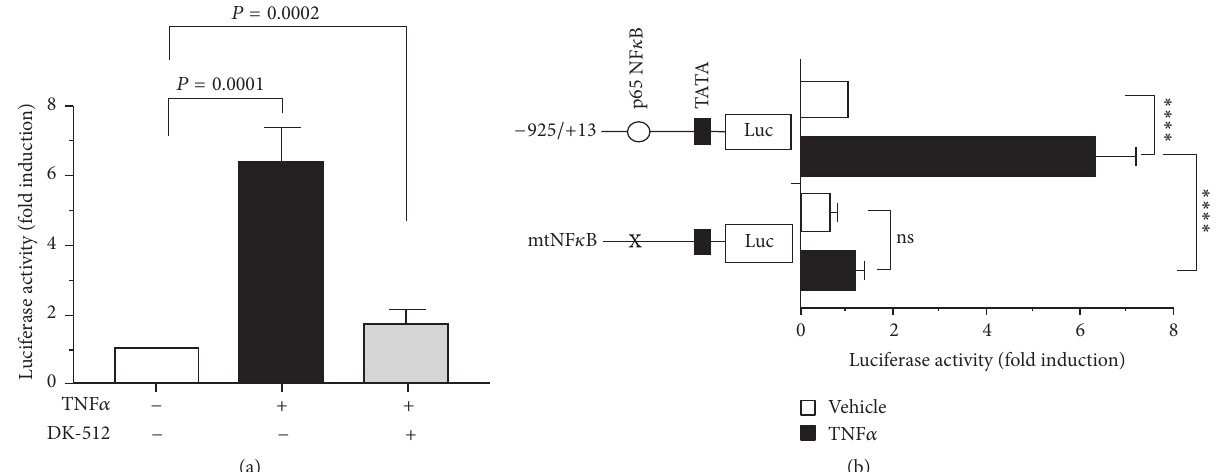
Figure 4: Effect of DK-512 and NF- 𝜅 B on the inhibition of TNF 𝛼 -induced MMP-9 gene promoter activity. (a) Promoter reporter assay. MDA- MB-231 cells were transfected with 0.2 𝜇 g of MMP-9 gene promoter reporter, pMMP9-Luc(–925/+13), along with 50 ng pRL-null. After 48 h, cells were pretreated with 5 𝜇 M DK-512 for 30 min before the addition of 10ng/mL TNF 𝛼 . After 8 h, cells were harvested and luciferase activities were measured. Firefly luciferase activity was normalized to Renilla luciferase activity. The data shown represent the mean ± SD ( 𝑛 = 3 ). 𝑃 value was analyzed by Sidak’s test. (b) Promoter reporter assay. MDA-MB-231 cells were transfected with wild-type construct, pMMP9-Luc(–925/+13), or NF- 𝜅 B site-mutant construct, pMMP9-Luc(–925/+13)mtNF 𝜅 B, along with 50 ng pRL-null. After 48 h, cells were treated and luciferase activities were measured as in (a). The data shown represent the mean ± SD ( 𝑛 = 3 ); ∗∗∗∗ 𝑃 < 0.0001 . 𝑃 value was analyzed by Sidak’s